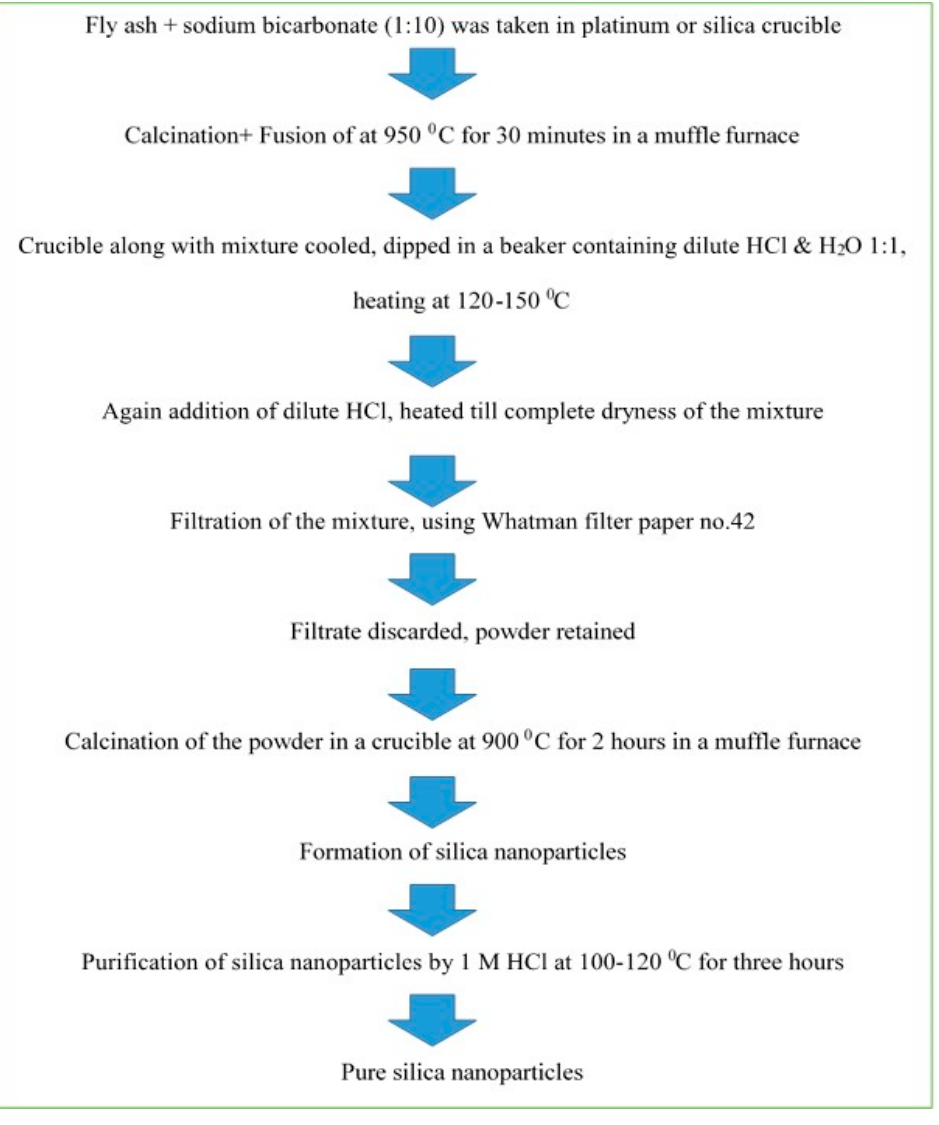
Figure 8. Steps involved in the silica synthesis and purification by chemical method. Table 6. Silica leaching and synthesis from fly ash by chemical